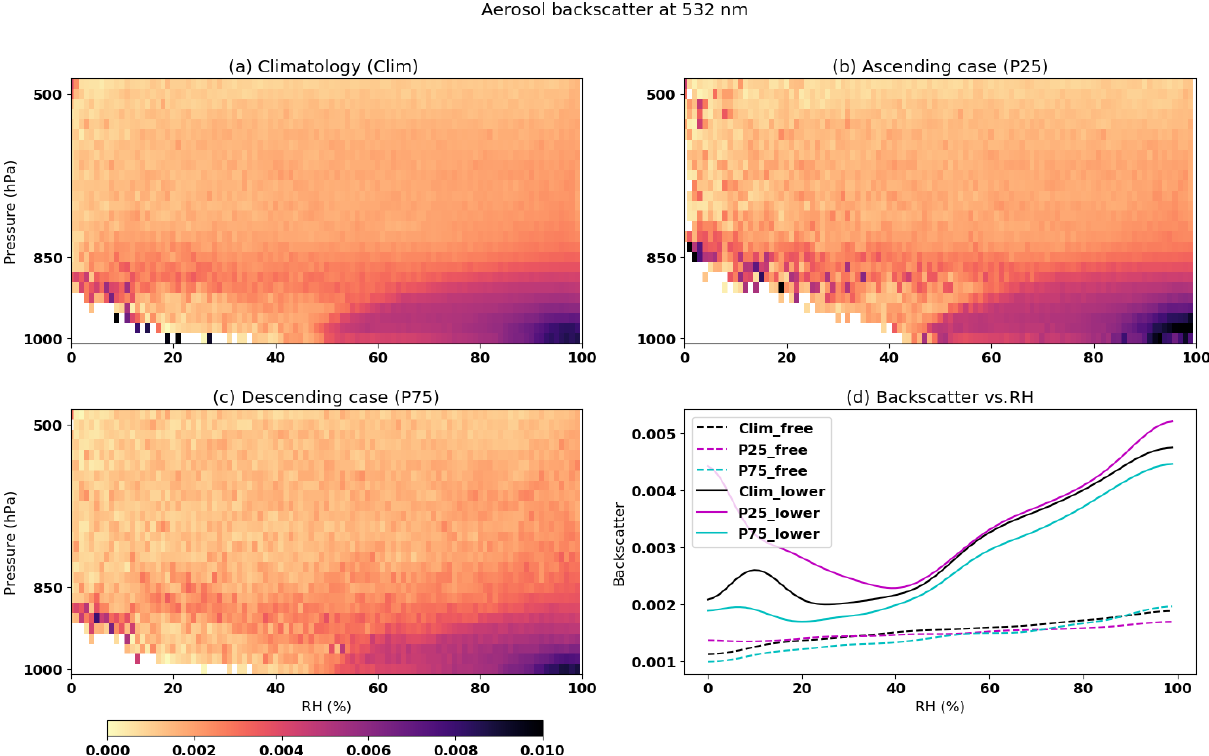
Figure 6. The vertical structure of the total backscatter coefficient at 532nm (km − 1 sr − 1 ) as a function of relative humidity: (a) climatolog- ical conditions, all aerosol profiles included; (b) ascending case, only when 700hPa geopotential height is less than 25th percentile (P25); (c) descending case, only when 700hPa geopotential height is greater than the 75th percentile (P75); and (d) expressed only as a function of relative humidity for two cases, i.e., free tropospheric aerosols (pressure < 850hPa) and lower-tropospheric aerosols (pressure >